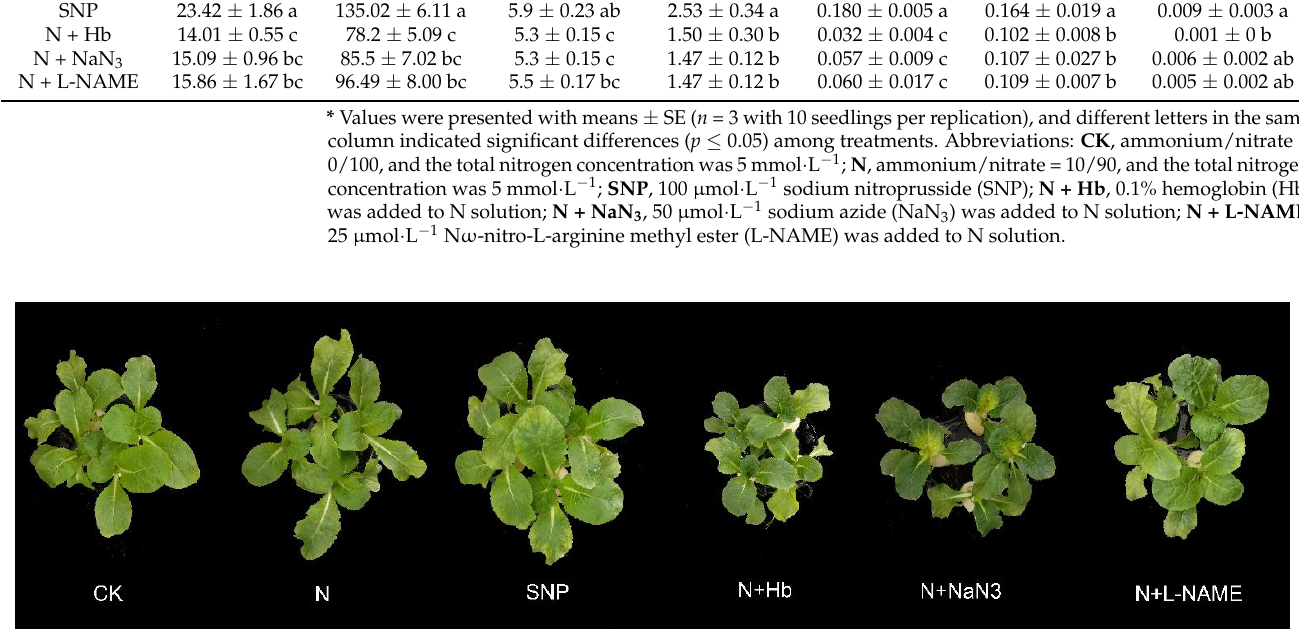
Figure 1. Effects of different ammonium/nitrate ratios, exogenous nitric oxide, and the addition of NO scavenger and biosynthesis inhibitors in ammonium/nitrate solution on shoot and root morphology of mini Chinese cabbage seedling exposed to low-light stress. Shoot morphology of 8-day-old mini Chinese cabbage seedlings cultivated in hydroponics system and fertilized with different treated solutions: CK, ammonium/nitrate = 0/100, and the total nitrogen concentration was 5 mM; N, ammonium/nitrate = 10/90, and the total nitrogen concentration was 5 mM; SNP, 100 µ mol/L sodium nitroprusside (SNP); N + Hb, 0.1% hemoglobin (Hb) was added to N solution; N + NaN 3 , 50 µ mol/L sodium azide (NaN 3 ) was added to N solution; N + L-NAME, 25 µ mol/L N ω -nitro-L-arginine methyl ester (L-NAME) was added to N